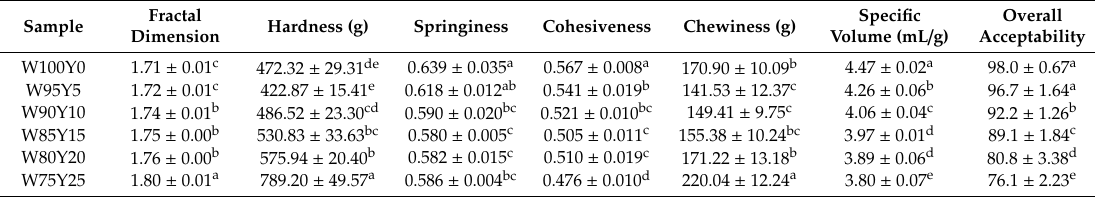
Figure 6. The effect of added yam flour on the characteristics of bread. Figure 6. The e ff ect of added yam flour on the characteristics of bread. Table 5. E ff ects of yam flour addition on texture properties of